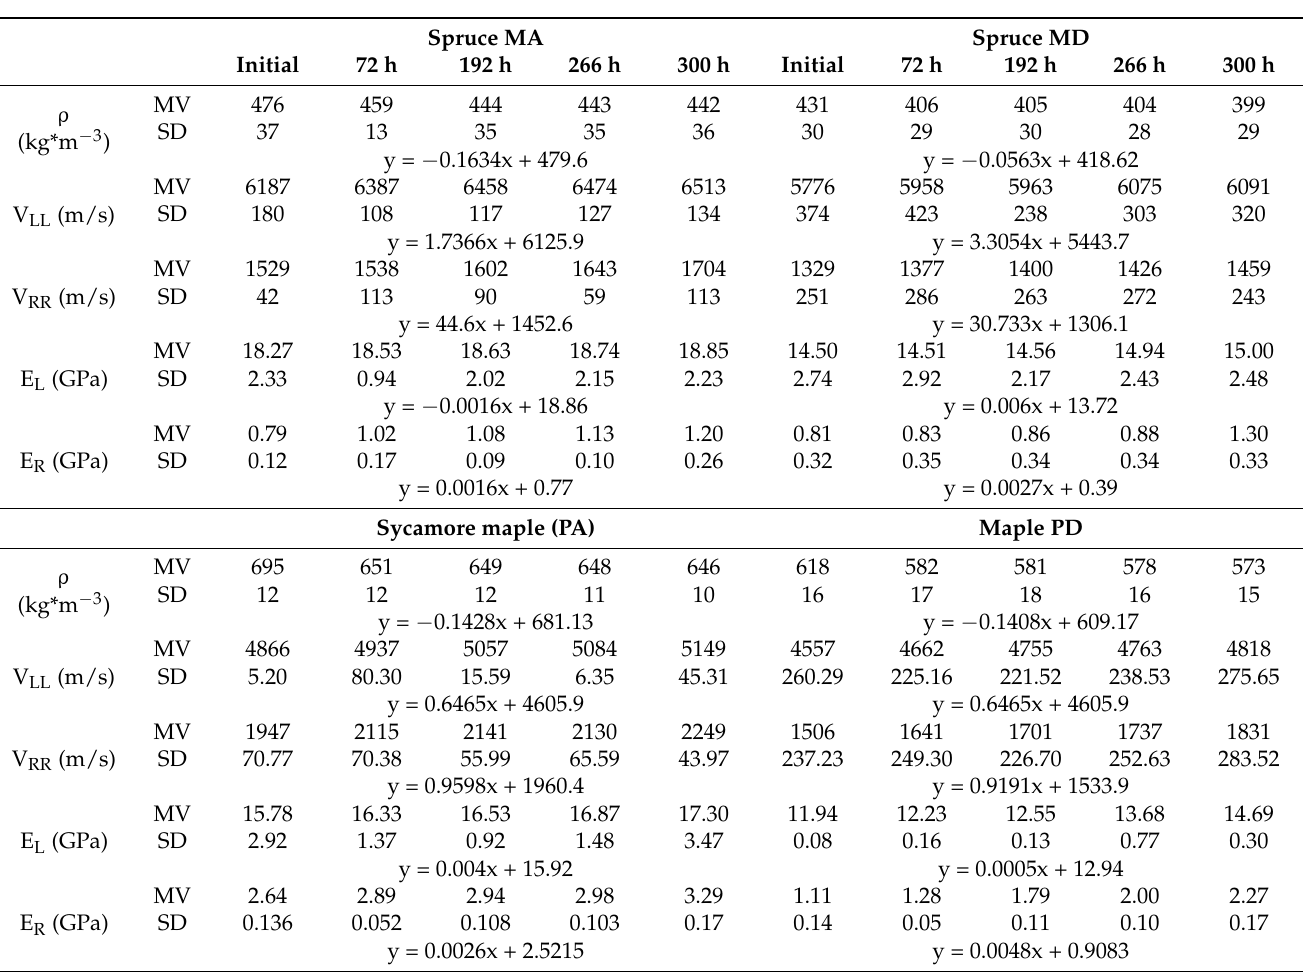
Table 4. Summary of acoustic and elastic parameters determined before and during exposure to UV. Legend: ρ —density (kg/m 3 ); V LL —sound velocity in wood in the longitudinal direction, (m/s); V RR —sound velocity in wood in the radial direction, (m/s); E L —elasticity modulus in the longitudinal direction (GPa); E R —elasticity modulus in the radial direction (GPa); MD—mean value; SD—standard deviation. Spruce MA Spruce MD